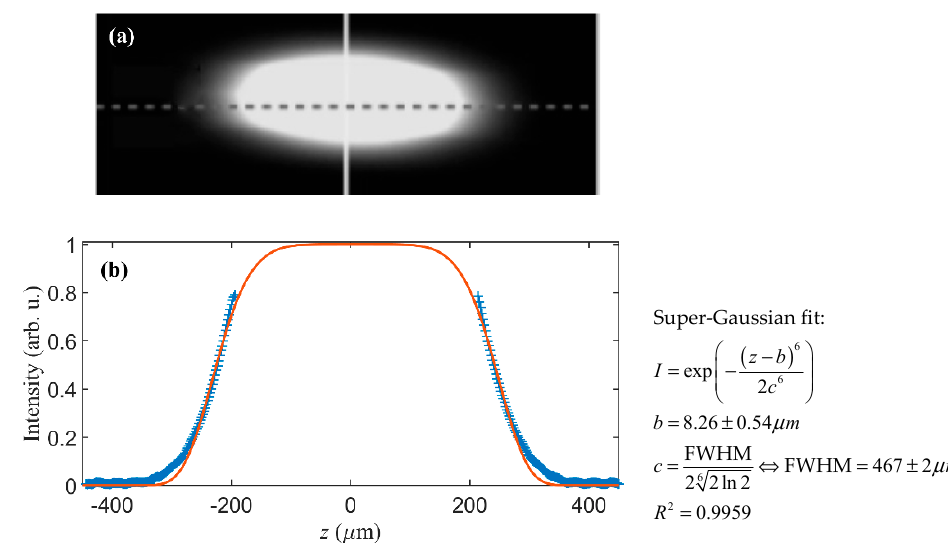
Figure 1. Beam heating profile in the fiber obtained with the LZM cameras ( a ) and correspondent super- Gaussian fit ( b ). The dots represent the collected data points and the red line represents a super-Gaussian fit.